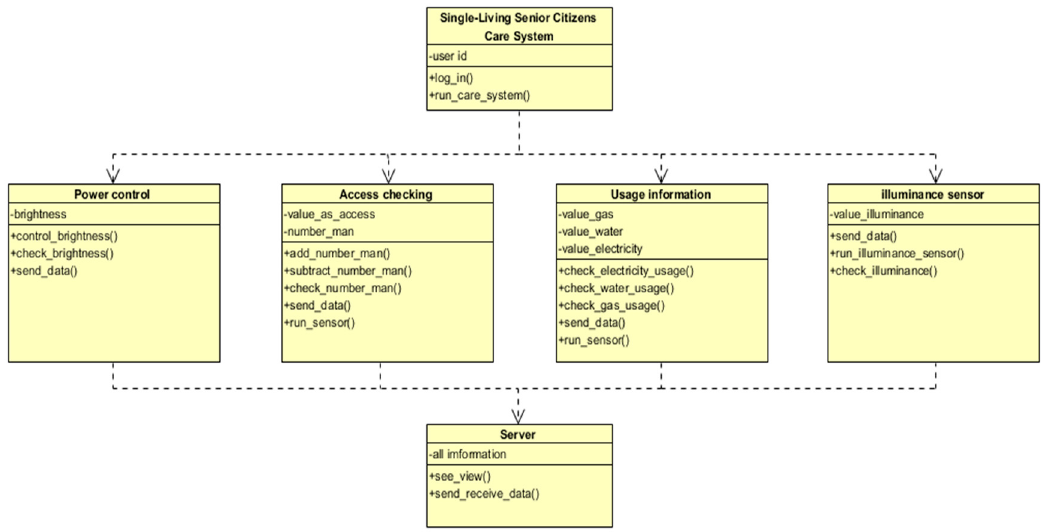
Figure 14. The Care System Unified Modeling Language (UML) Implemented with Java Android.